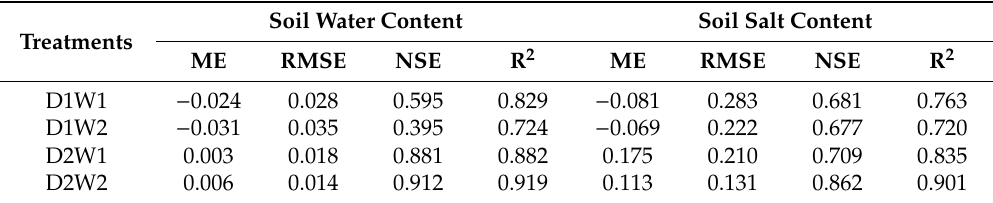
Table 3. Statistical errors parameters (RMSE, MAE, ME, R 2 ) for the comparison between measured and simulated soil water and salt contents (EC 1:5 ) in di ff erent treatments.